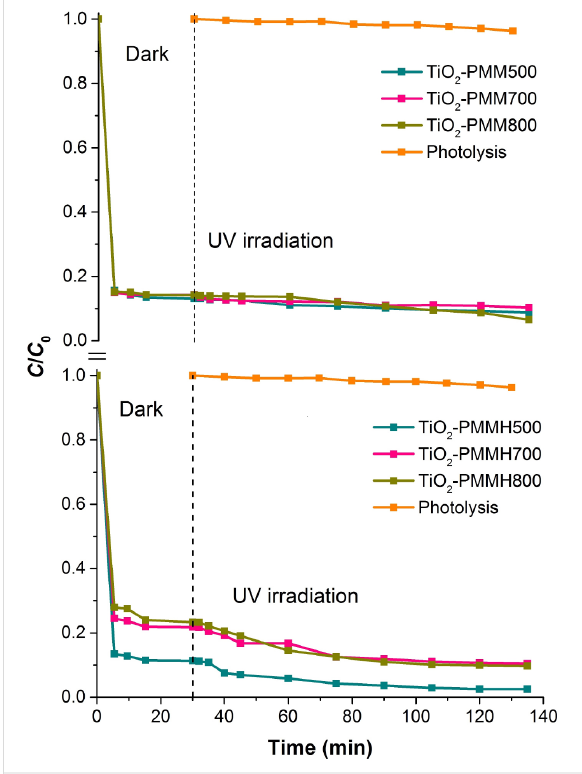
Figure 11: Removal of RhB on the TiO 2 -PMM x , TiO 2 -PMM Н x sam- ples used as photocatalysts and those without photocatalyst under dark and under UV irradiation